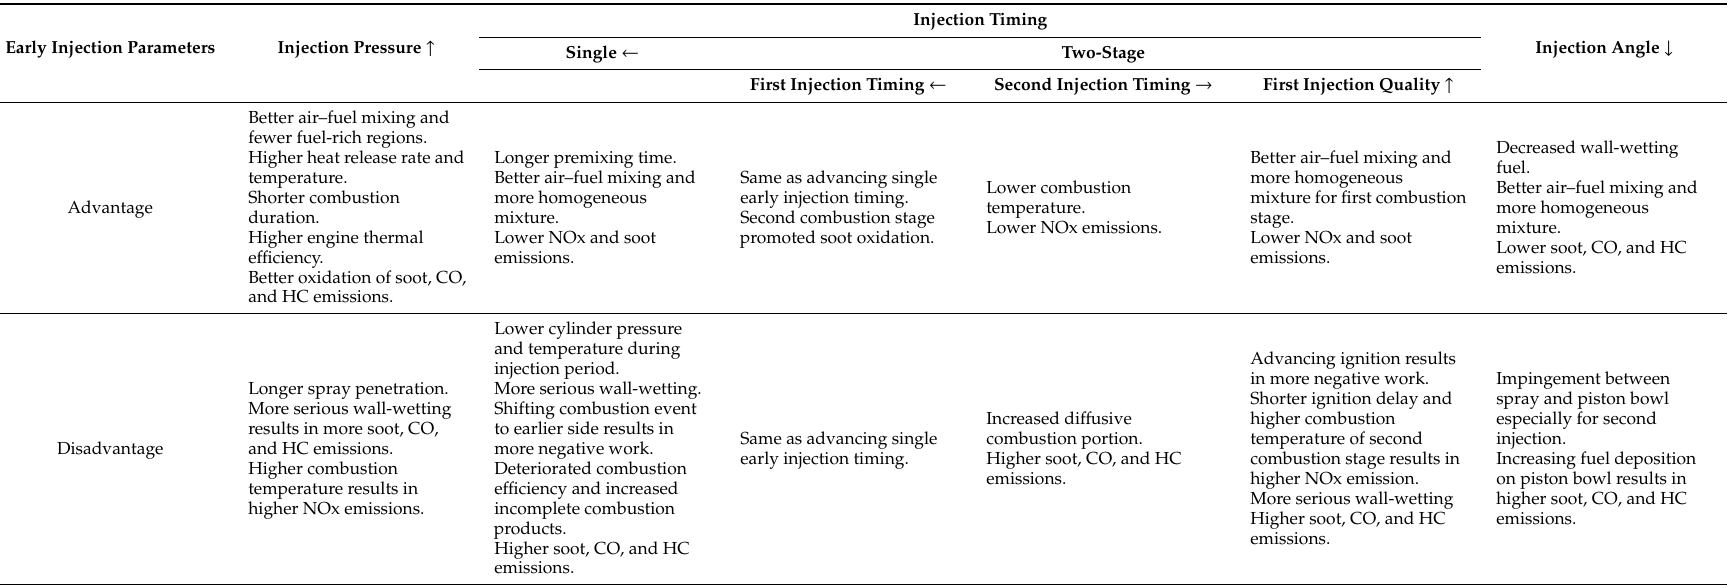
Table 9. Advantages and disadvantages of early injection